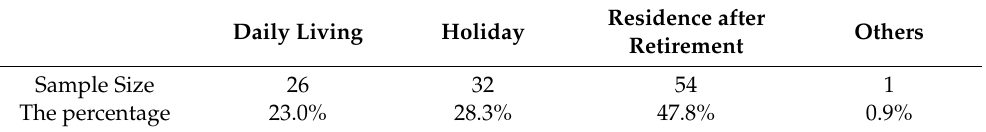
Table 6. The main purpose of buying or renting a farmhouse. Daily Living